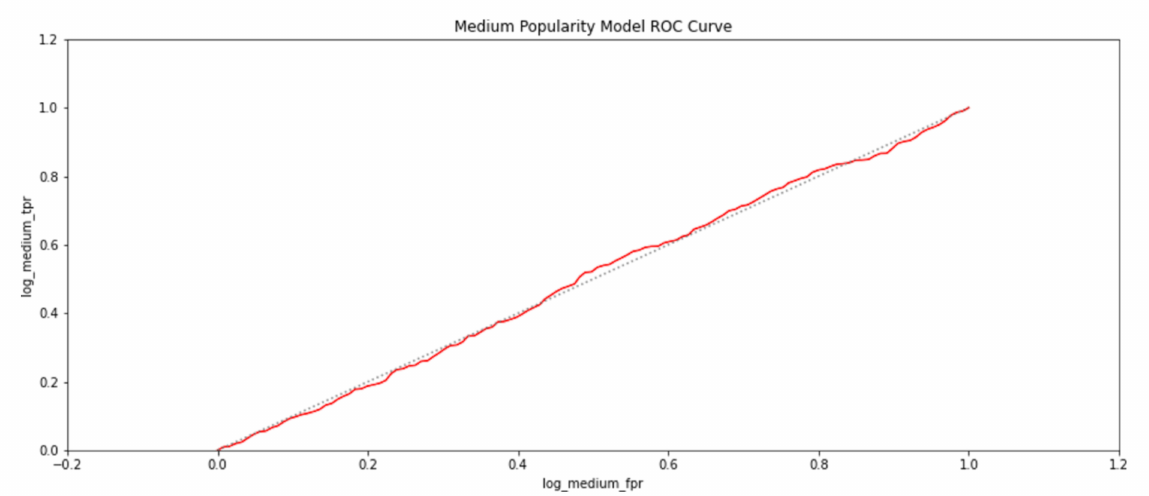
Figure 16. The probability of an exhibit area being in a medium popular category as identified by a logistic regression- based classifier.